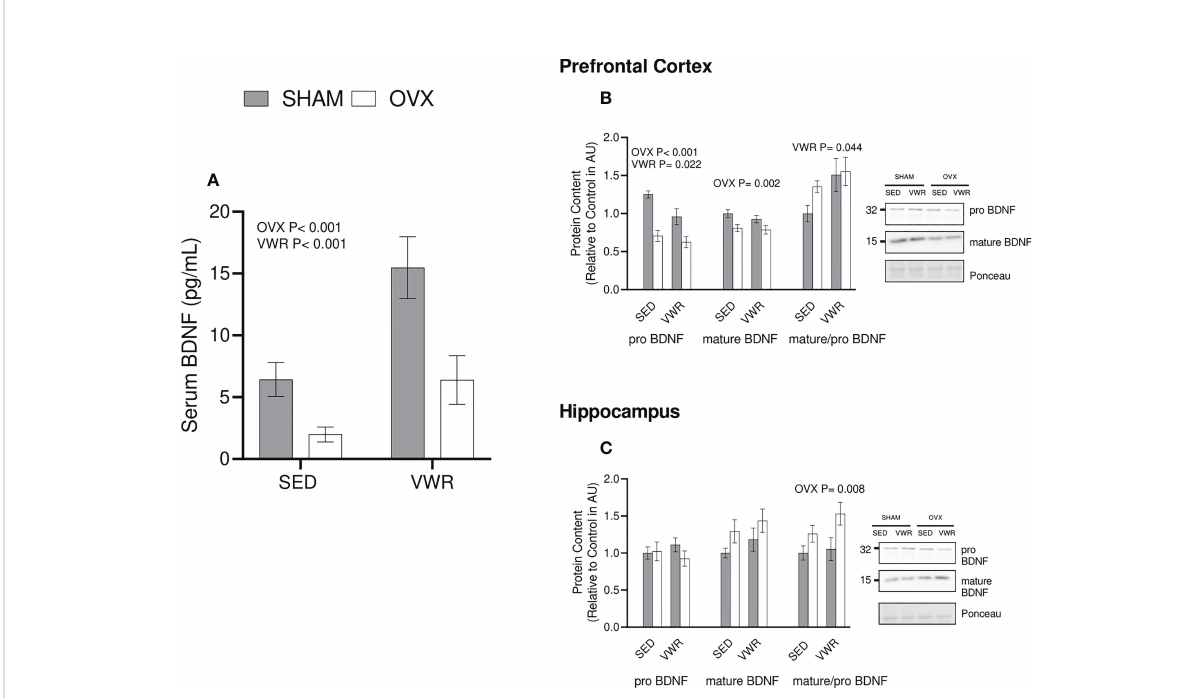
FIGURE 4 BDNF Content. (A) Serum BDNF as measured through ELISA (pg/mL) (B) Prefrontal cortex proBDNF, matureBDNF (AU) and mature/pro BDNF ratio. (C) Hippocampus proBDNF, matureBDNF (AU) and mature/pro BDNF ratio. All graphs are accompanied by representative blots. All data analyzed using a two-way ANOVA. BDNF, brain derived neurotrophic factor; AU, arbitrary units; SED, sedentary; VWR, voluntary wheel running; OVX, ovariectomized; SHAM, sham operated. Signi fi cance is set to P ≤ 0.05; n=10 per